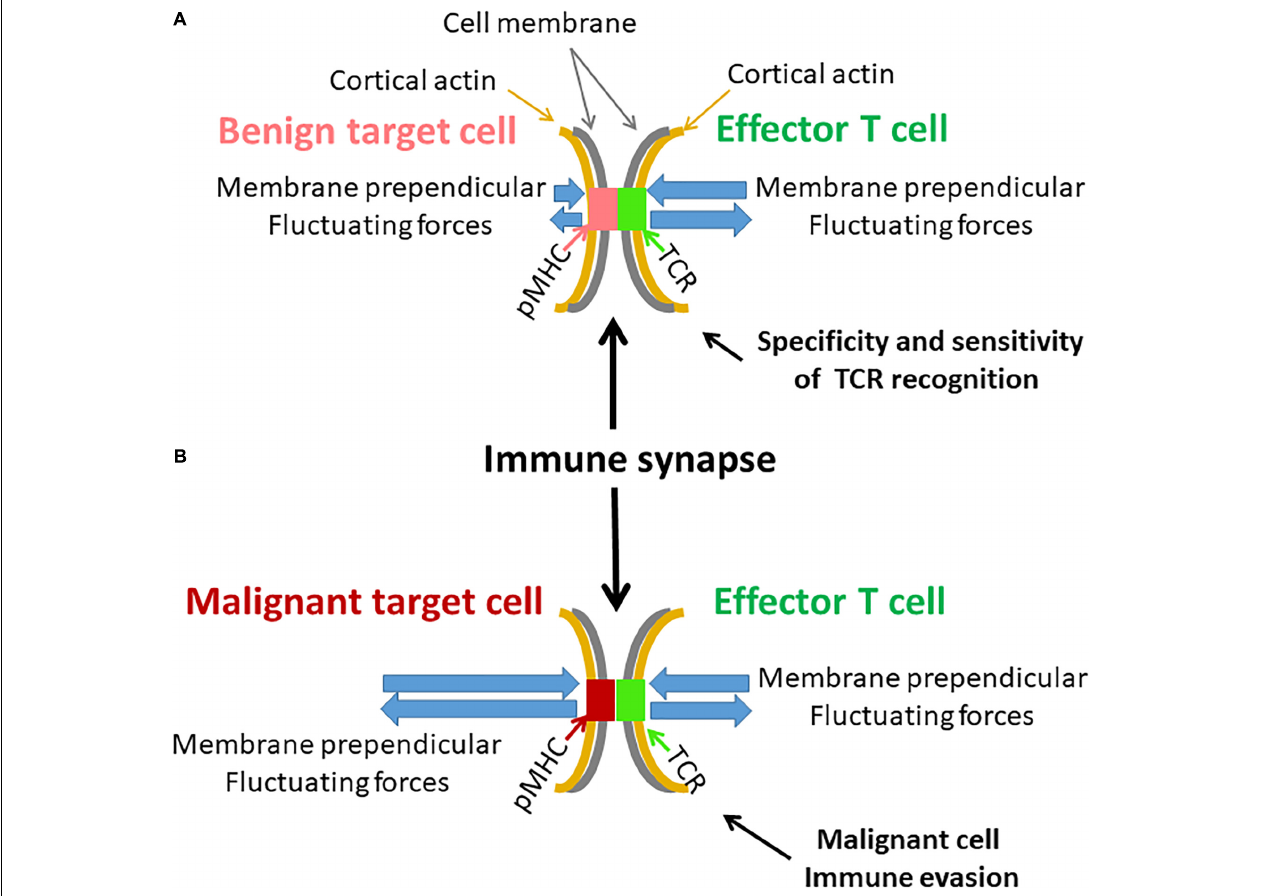
FIGURE 11 | Possible effects of cell membrane fluctuations on T cell function. (A) An illustration of an immune synapse between an effector T cell with its specific TCR and a benign target cell with a complimentary pMHC. Both cell membranes and their attached cortical actin are mechanically vibrating but to a different extent. Resultant perpendicular forces act on the TCR-pMHC complex, leading to its modified lifetime. The benign target cell membrane is relatively firm and stable. The more pronounced membrane fluctuations of the effector T cell could effectively produce repeated and precise rupture forces on the TCR-pMHC complex to generate effective cellular response. (B) A similar illustration of an immune synapse between effector T cell and a malignant target cell. The malignant target cell membrane and its underlying cortical actin are less firm and fluctuate more relative to benign cells [as in panel (A) ]. The fluctuations of the effector T cell are milder relative to the membrane fluctuations of the malignant target cell. Thus, the TCR-pMHC complex is subject to incoherent forces, abrogating precise and organized activation of the TCR and the effector T cell. This may further lead to possible immune evasion of the malignant cell.